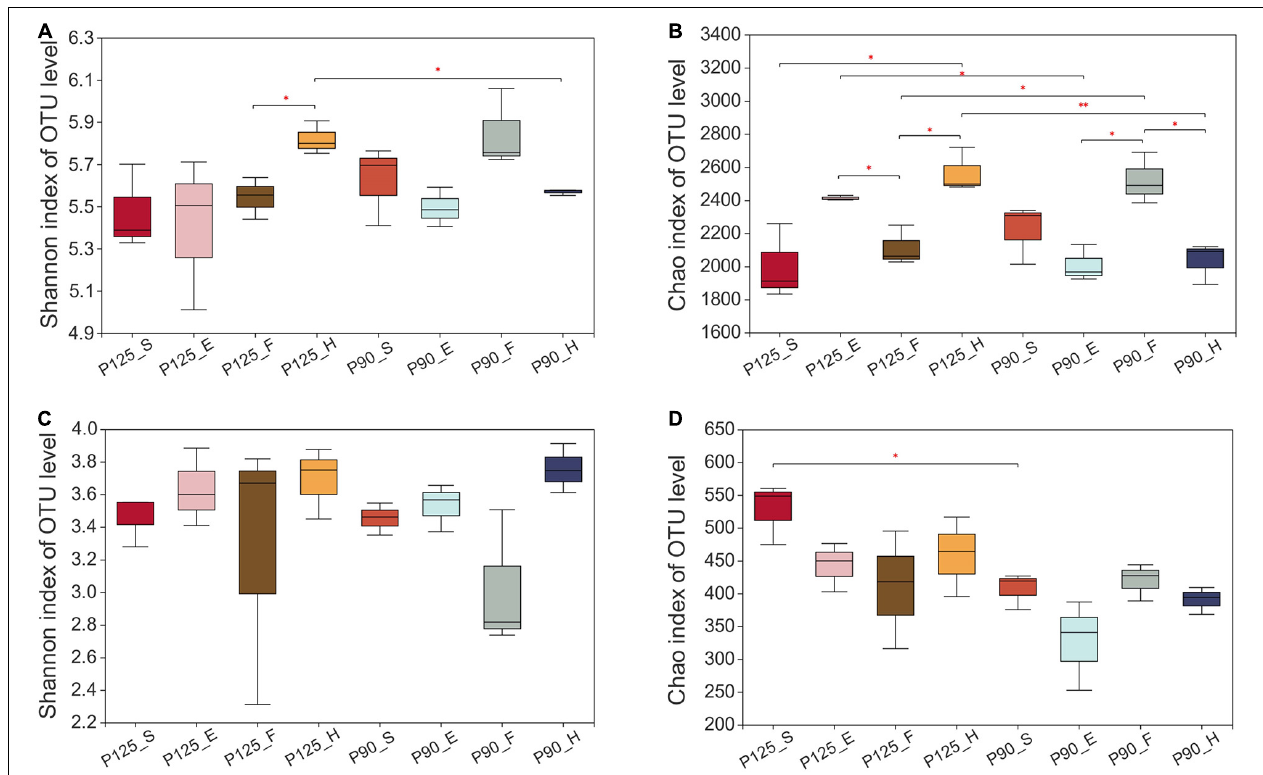
FIGURE 1 | Alpha diversity of the bacterial and fungal communities in the four growth stages of maize—seedling stage ( S ), ear stage ( E ), flowering stage ( F ), and harvest stage ( H )—under conventional treatment (P125, with a rate of 125 kg P 2 O 5 ha − 1 ) and optimal treatment (P90, with a rate of 90 kg P 2 O 5 ha − 1 ). (A,B) Shannon diversity index (A) and Chao richness index (B) of the bacterial community. (C,D) Shannon diversity index (C) and Chao richness index (D) of the fungal community. Significant differences between the same growth periods under two treatments were compared using Welch’s t -test. ∗ 0.01 < p ≤ 0.05; ∗∗ 0.001 < p ≤